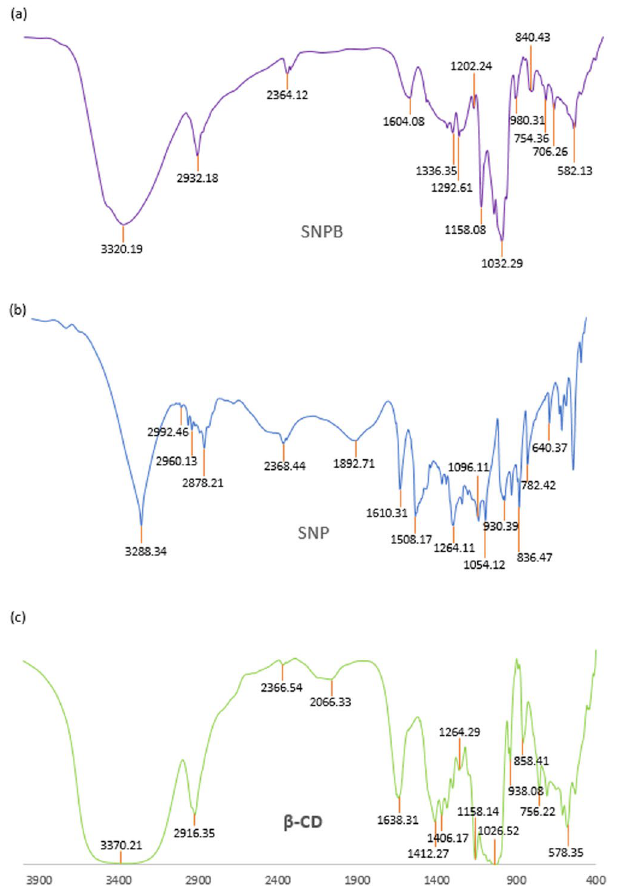
Figure 14. (a , b , c) FTIR spectra of (a) SNP + β -CD, (b) SNP, (c) β